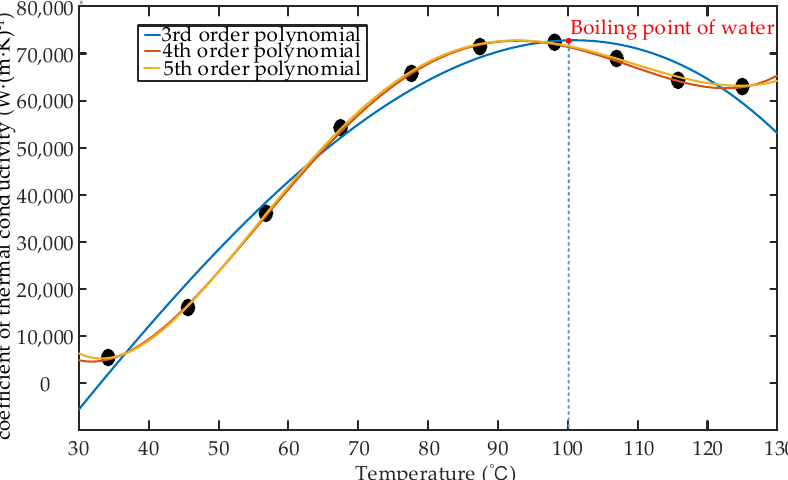
Figure 8. Relationship between the coefficient of thermal conductivity of the heat pipe and temperature.